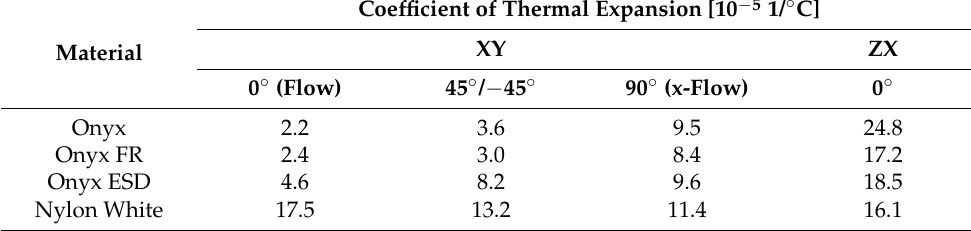
Table 2. CTE values based on print orientation and infill